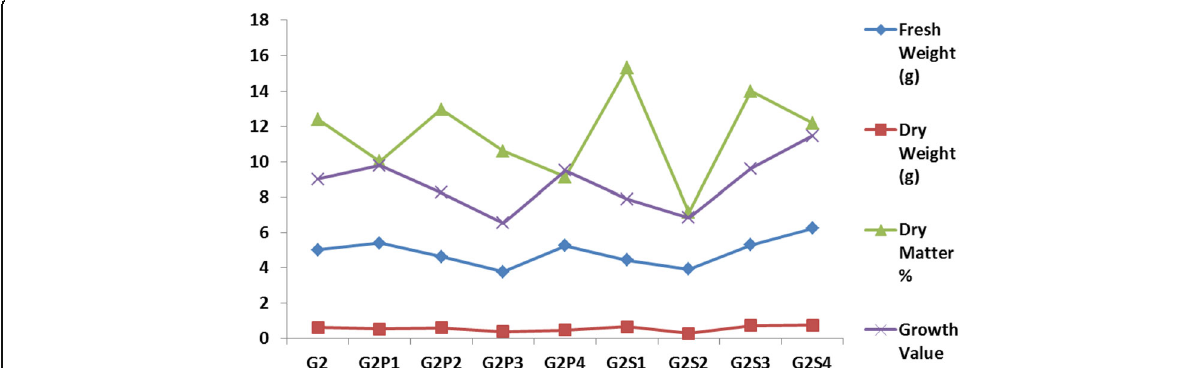
Fig. 3 Callus growth measurements in the first harvest. G2 control = 4 mg/l TDZ, G2P1 = 4 mg/l TDZ + 2 mg/l PA, G2P2 = 4 mg/l TDZ + 3 mg/l PA, G2P3 = 4 mg/l TDZ + 4 mg/l PA, G2P4 = 4 mg/l TDZ + 5 mg/l PA, G2S1 = 4 mg/l TDZ + 34.5 mg/l SA, G2S2 = 4 mg/l TDZ + 69 mg/l SA,